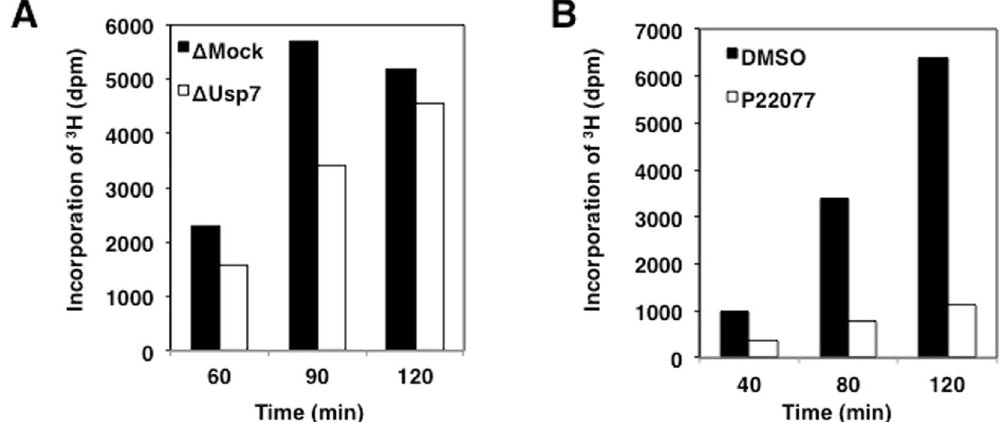
Figure 6. Usp7 plays a key role in efficient DNA methylation. ( A ) Sperm chromatin was added to either mock- or Usp7-depleted extracts in the presence of radiolabelled S-[methyl- 3 H]-adenosyl-L-methionine. The efficiency of DNA methylation was measured at the time points indicated. ∆ Denotes immunodepletion of the protein indicated. ( B ) Interphase egg extracts were treated with 100 μ M P22077. The efficiency of DNA methylation was measured at the indicated time points as in ( A ).